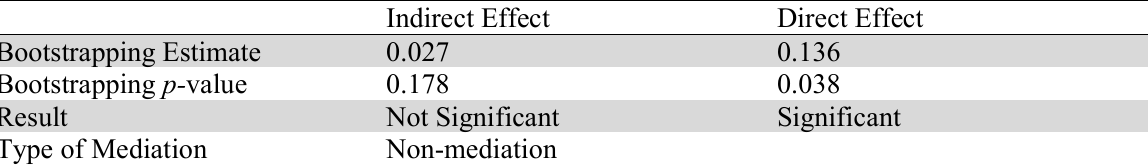
The Results of Direct and Indirect Effects (Perceived Behavioral Control = PB, Personal Values = PV, and Intention to Use =